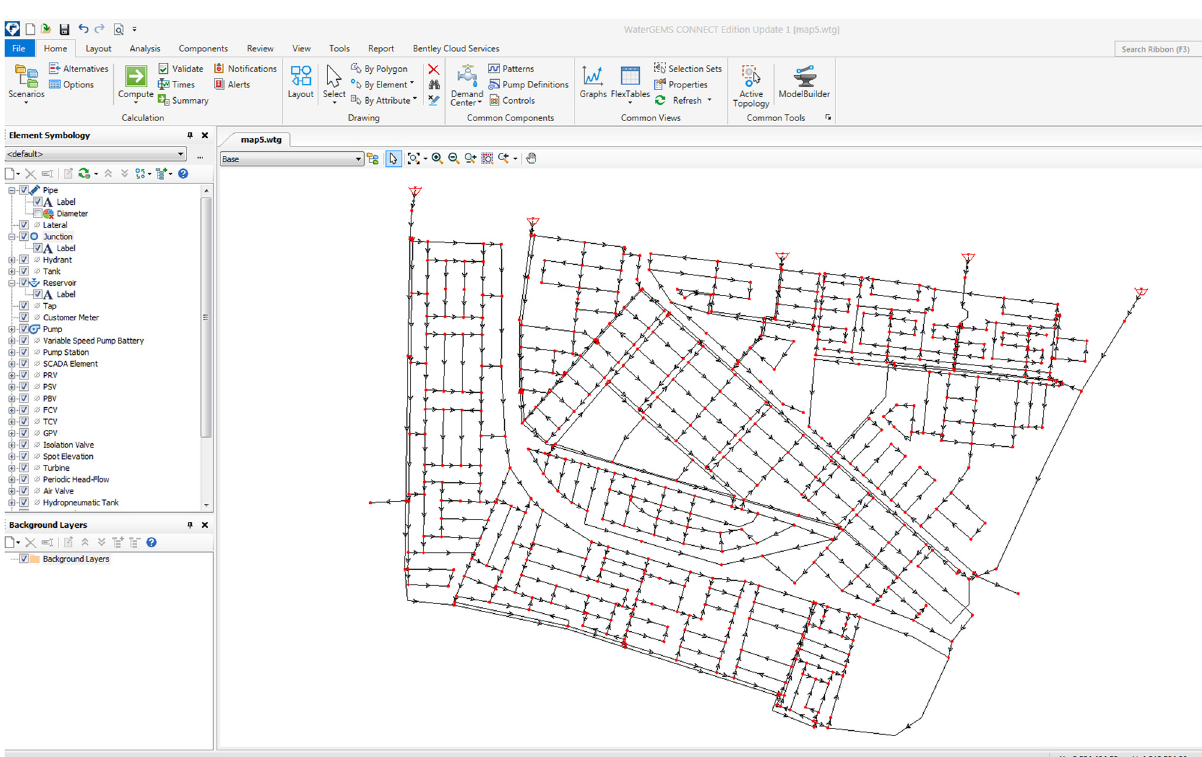
Figure 5: Results output example for the al - Yarmouk water network